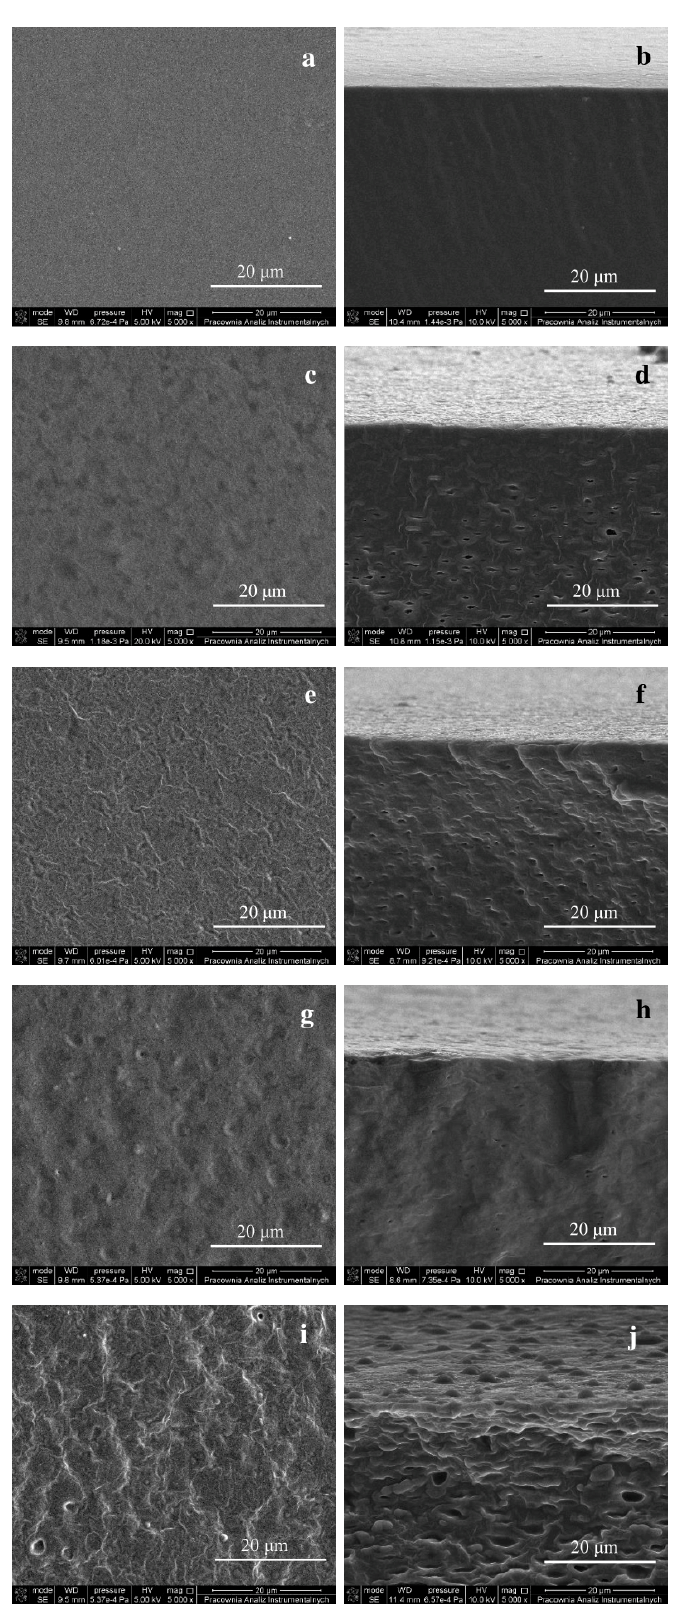
Figure 2. SEM images of the surface (left column) and fracture (right column) of the plasticized alginate films containing TO, viewed at a magnification of 5000 × : Alg + G ( a , b ), Alg + G + TO 1% ( c , d ), Alg + G + TO 1.33% ( e , f ), Alg + G + TO 1.67% ( g , h ), and Alg + G + TO 2% ( i , j